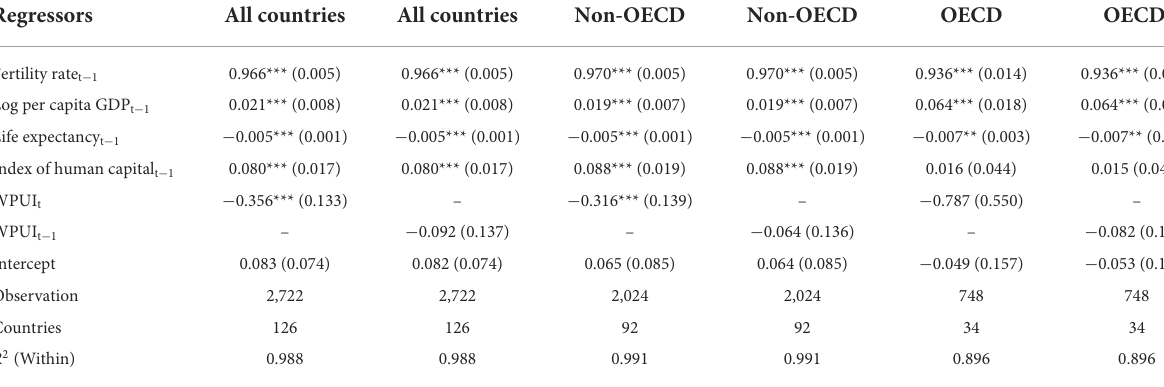
TABLE 4 Persistent fertility rates: fixed-effects estimations for Model I